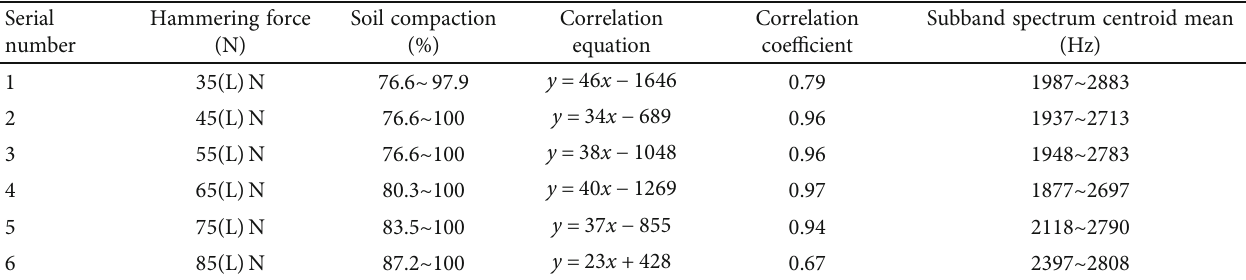
Table 4: Correlation table between the same level of hammering force and di ff erent compaction of soil samples and the subband spectrum centroid mean